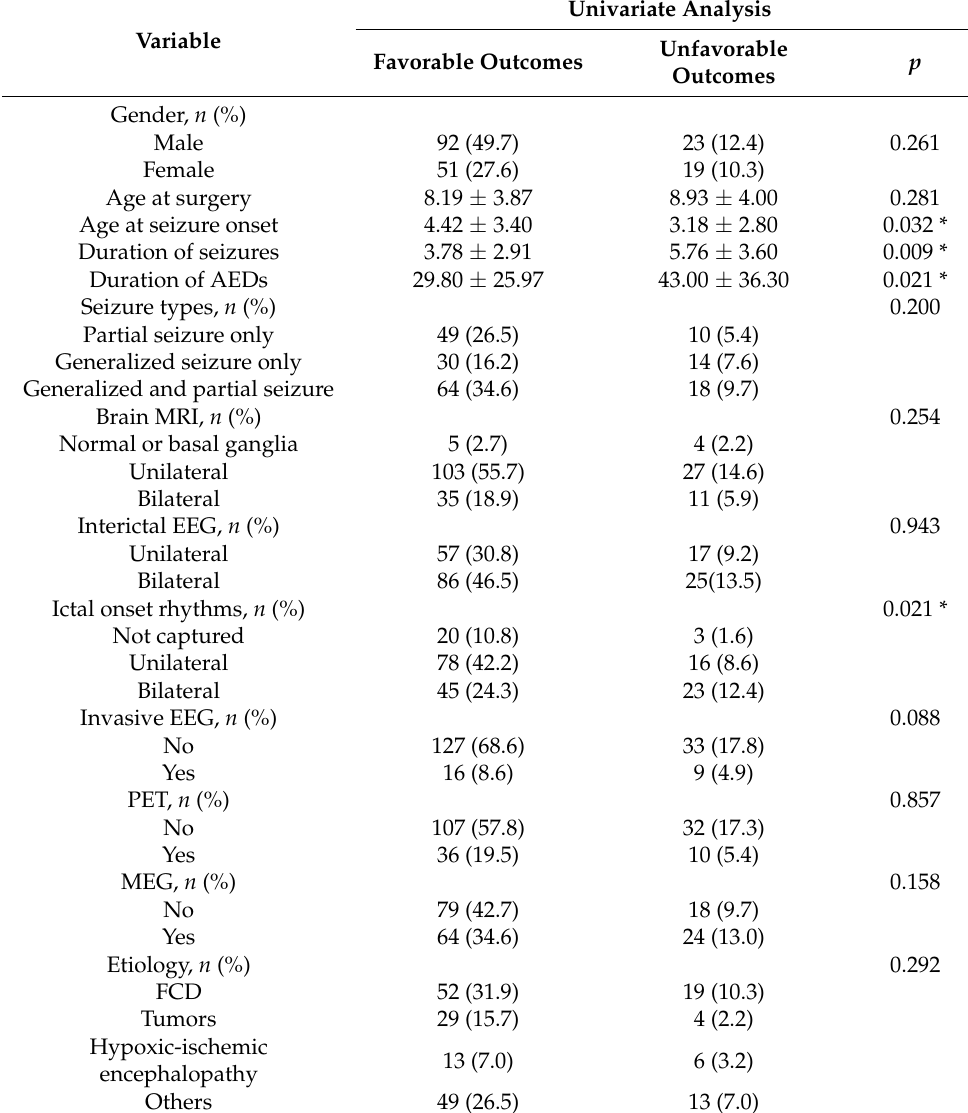
Table 2. Clinic characteristics of patients in resection surgery group and their relationship with seizure outcomes ( n = 185). Univariate Analysis Variable Unfavorable Favorable Outcomes Outcomes